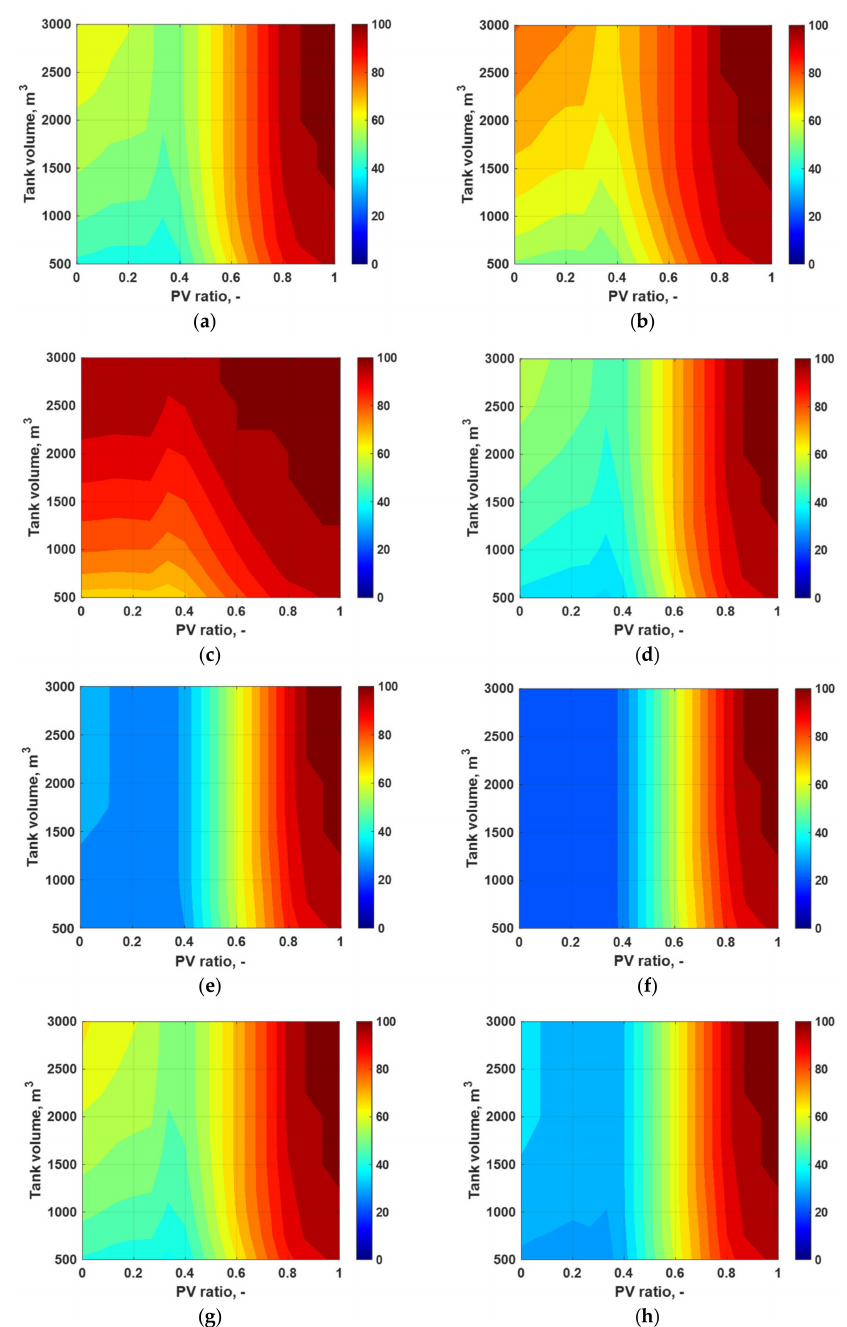
Figure 12. Variation of SCR (%) for Burgas (wine grapes) with a 15 kW HRES using pSi PV technology for different WT types: ( a ) Type 1; ( b ) Type 2; ( c ) Type 3; ( d ) Type 4; ( e ) Type 5; ( f ) Type 6; ( g ) Type 7; ( h ) Type